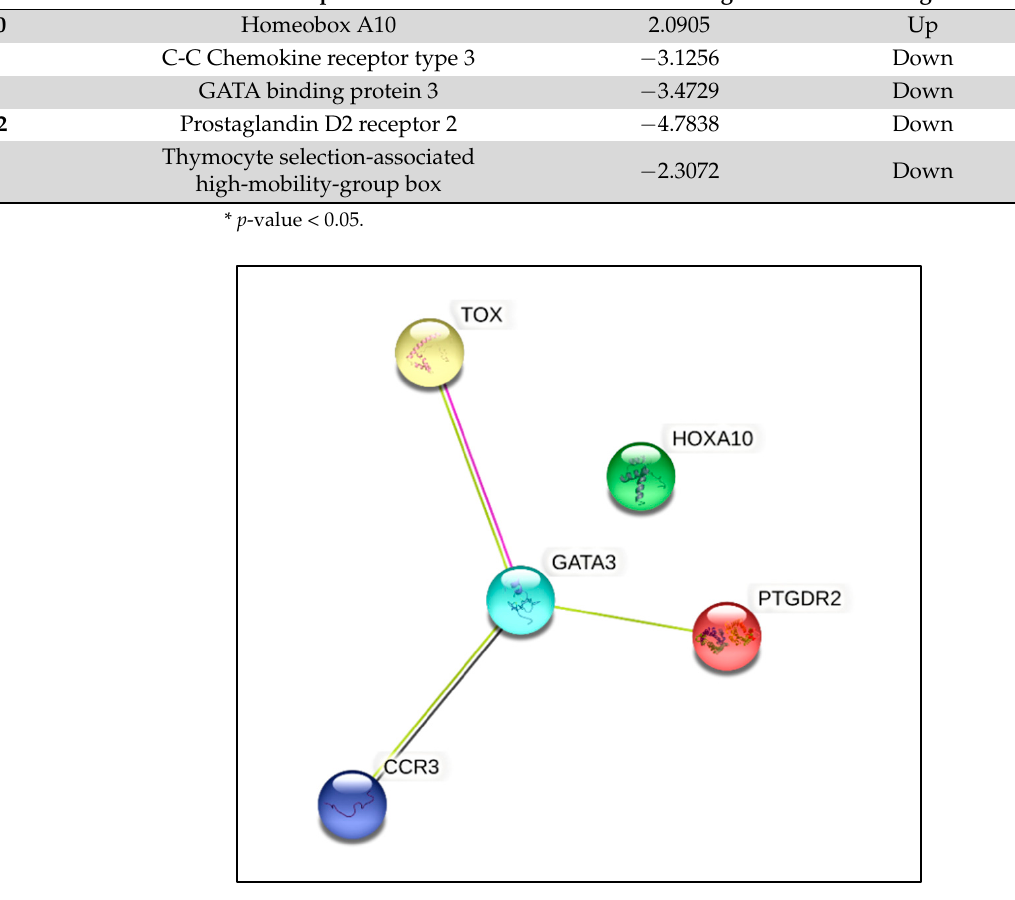
Figure 4. Protein interaction of significantly dysregulated genes. Protein–protein interaction and cluster analysis of the five differentially regulated genes from human T-helper cell differentiation array generated using the STRING Consortium 2022 software (version 11.5). There were five nodes and three edges. The PPI enrichment was found to be statistically significant ( p <